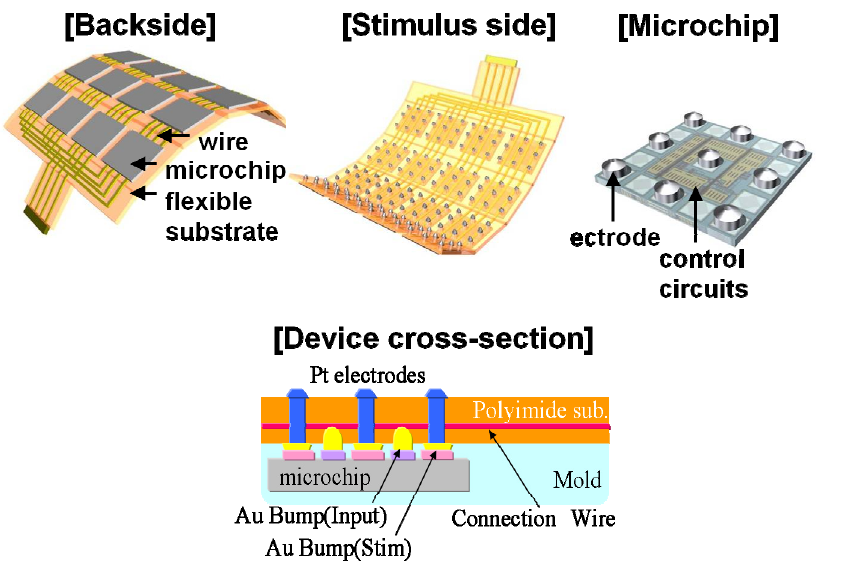
Figure 10. Multiple microchip architecture for a flexible retinal stimulator having a large number of stimulus